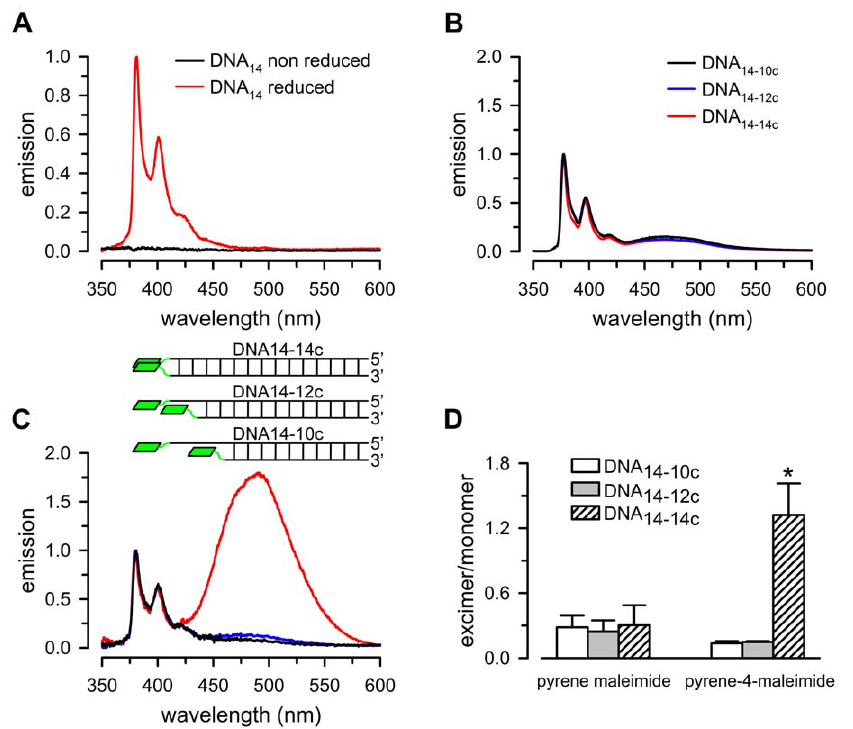
Figure 3. Emission of pyrene compounds reacted with thiol-modified DNA. A. Emission spectra of single-stranded DNA containing a 5 9 end thiol group (DNA 14 ) reacted with pyrene-4-maleimide. Data were normalized to peak 1 intensity from reduced DNA 14 . [DNA 14 ] was 0.5 m M, and [pyrene-4-maleimide] was 2 m M. B. Emission spectra of double-stranded DNA reacted with pyrene maleimide. DNA 14-14c : DNA 14 annealed to fully complementary DNA with a 3 9 end thiol group (DNA 14c ). DNA 14-12c : DNA 14 annealed to a 3 9 end two-base shorter complementary oligonucleotide with a 3 9 end thiol group. DNA 14-10c : DNA 14 annealed to a 3 9 end four-base shorter complementary oligonucleotide with a 3 9 end thiol group. C. Emission spectra of double-stranded DNA reacted with pyrene-4-maleimide. Insert: schematic representation of the experimental system showing the double-stranded DNAs labeled with pyrene-4-maleimide. The pyrenes are represented by green rhomboids. Data in panels B and C were normalized to peak 1 intensity. The labels in panel B also apply to panel C. D. Excimer/monomer emission ratio. The values were calculated as: excimer/ monomer=I peak 4 /I peak 1 , where I is the highest intensity of the peak, and peak 1 and peak 4 correspond to the excimer and monomer emission peaks. Averages 6 SEM from experiments such as those shown in panels B and C (n=3 for pyrene maleimide, and n=4 for pyrene-4-maleimide). The asterisk denotes P , 0.05 for the pyrene-4-maleimide DNA 14-14c adduct vs. each of the other adducts presented in panel D. The concentrations of the fluorescent probes and double-stranded DNA were 4 m M and 0.5 m M,